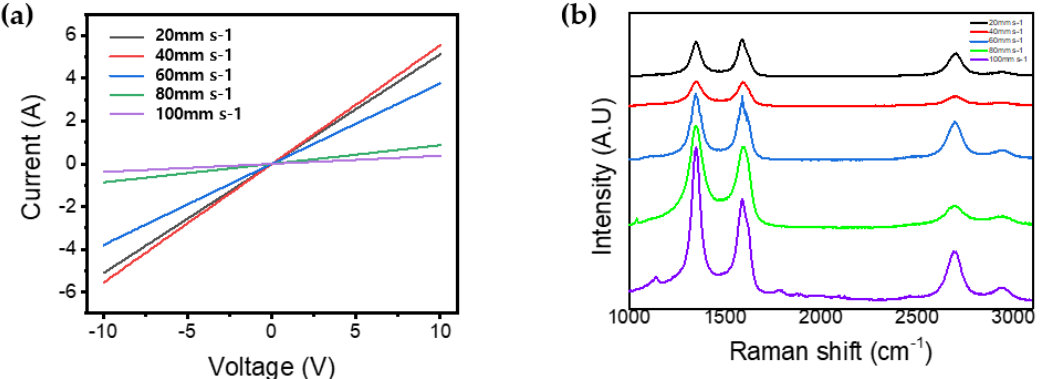
Figure 8. ( a ) I–V characteristics. ( b ) Raman spectra of patterns. Table 5. I D / I G values of the as-prepared patterns calculated from the Raman analysis. Laser Speed (mm/s)